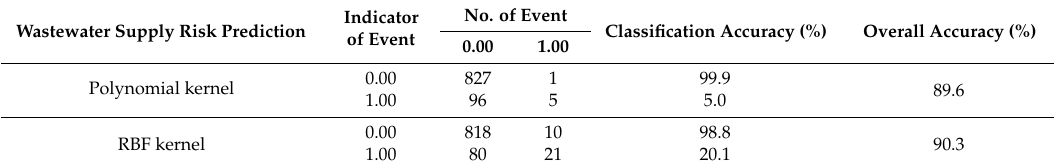
Table 4. Analysis of wastewater risk prediction model using SVM.